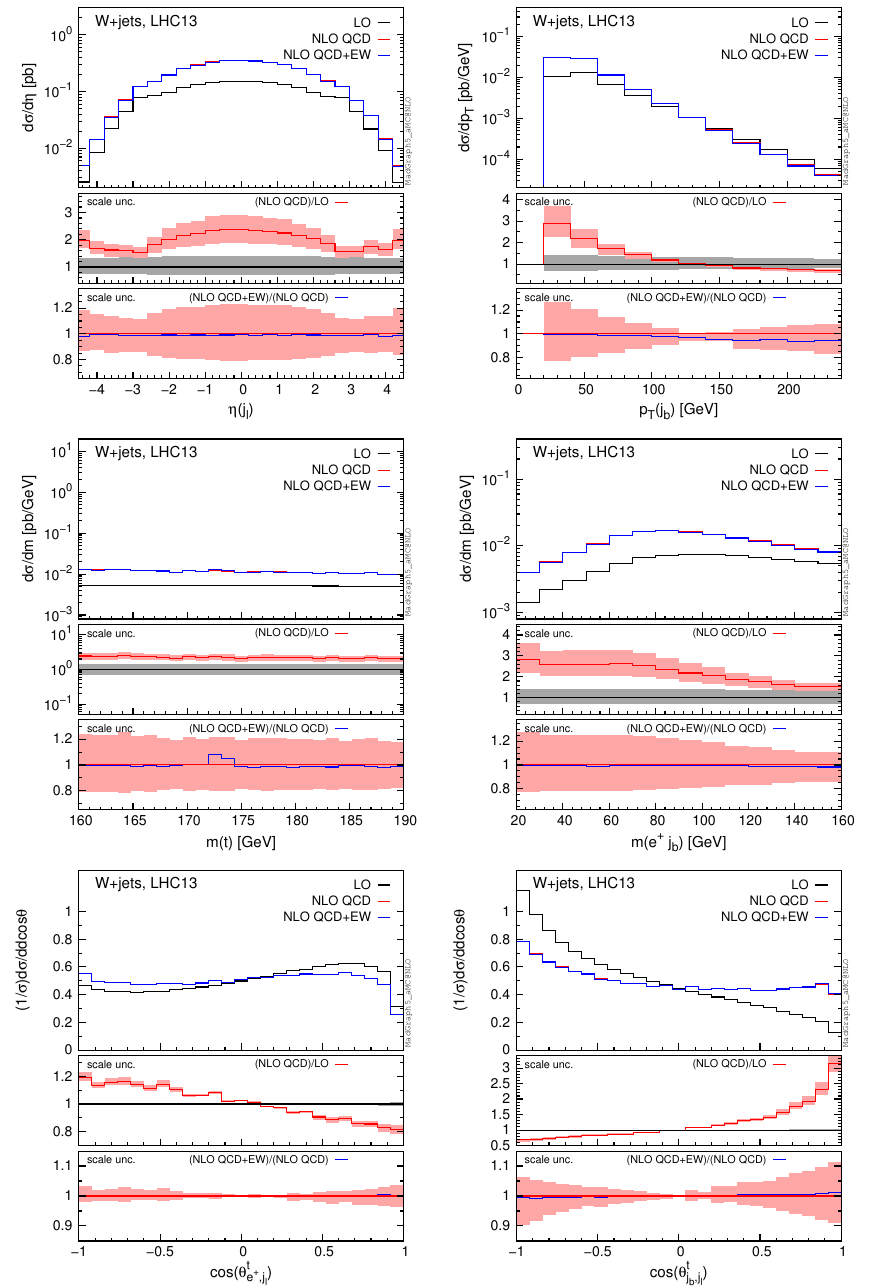
Figure 4 . LO, NLO QCD and NLO QCD+EW predictions for the observables from (cid:12)gures 2 and 3 that show non-(cid:13)at e(cid:11)ects from either NLO QCD or NLO EW corrections for the W +jets process.